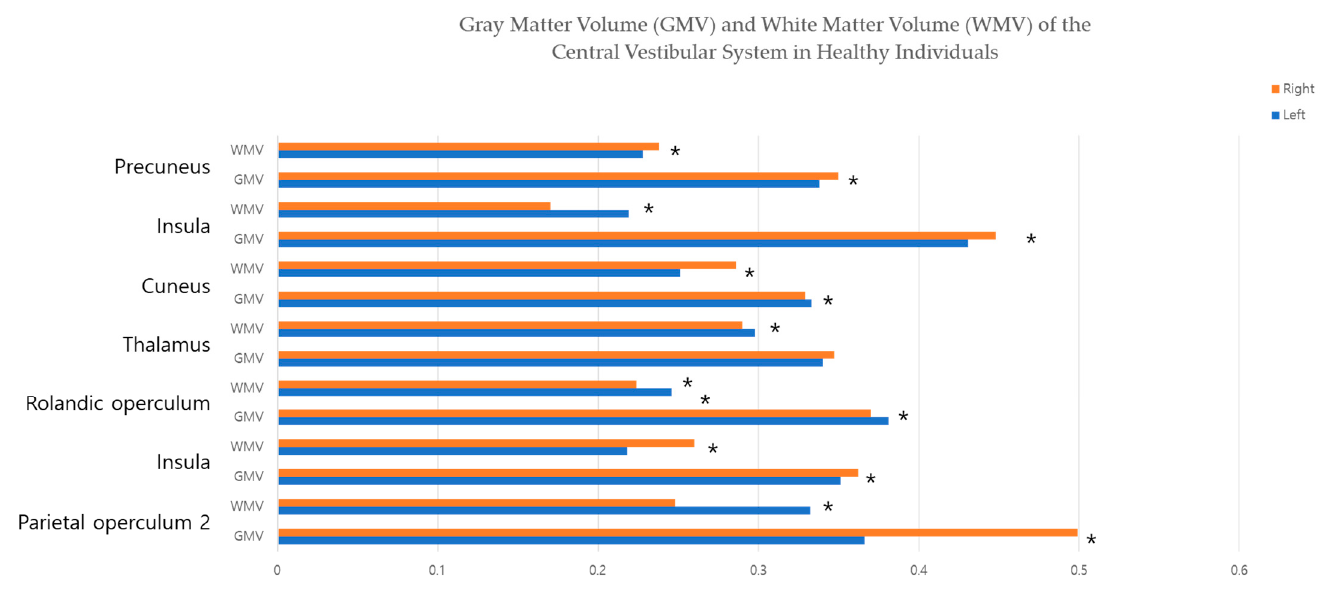
Figure 4. Gray-Matter Volume (GMV) and White-Matter Volume (WMV) of the Central-Vestibular System in Healthy Individuals. * statistically significant